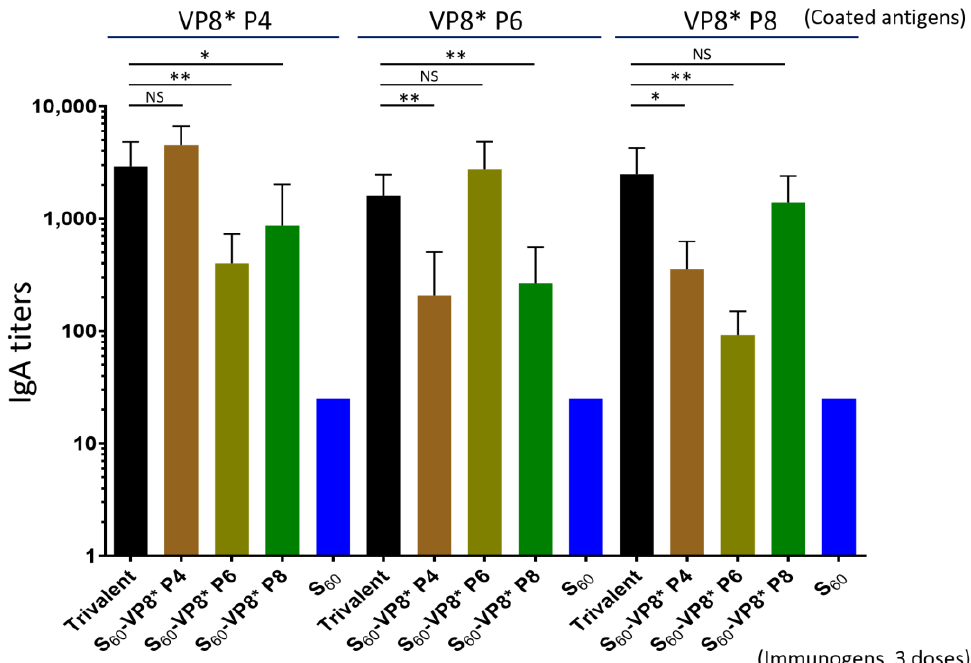
Figure 5. The trivalent S 60 -VP8* PVNP vaccine (trivalent) induced higher and broader serum IgA responses in mice toward the three homologous VP8* antigens (black columns) compared with those elicited by the three single-valent S 60 -VP8* PVNPs (brawn/cyan/green columns) after three immunizations. The Y -axis shows the VP8*-specific serum IgA titers, while the X -axis shows different vaccines or immunogens, as indicated. Statistical differences between data groups with corresponding p -values are calculated and shown in the Supplementary Materials . “ns” , non-significant for p -values >0.05; “*”, significant for p -values <0.05; “**”, highly significant for p -values <0.01.